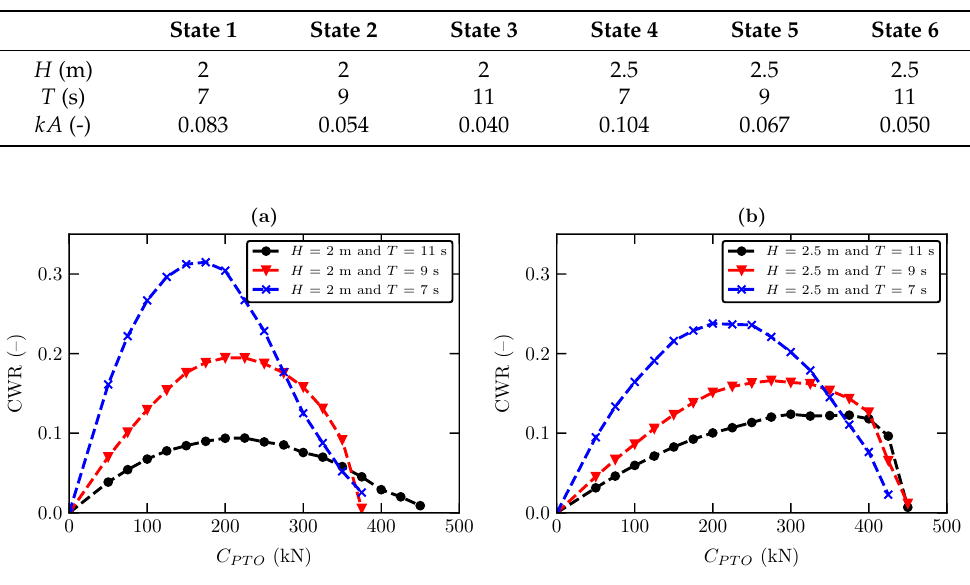
Table 3. Regular wave conditions considered in the numerical tests.